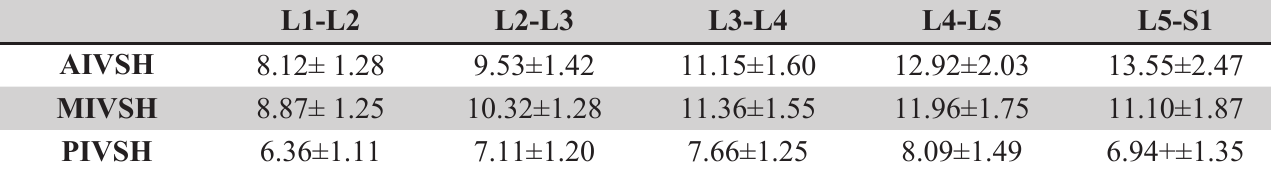
Table 1. Intervertebral space height at various vertebral levels (Mean±SD) in mm.